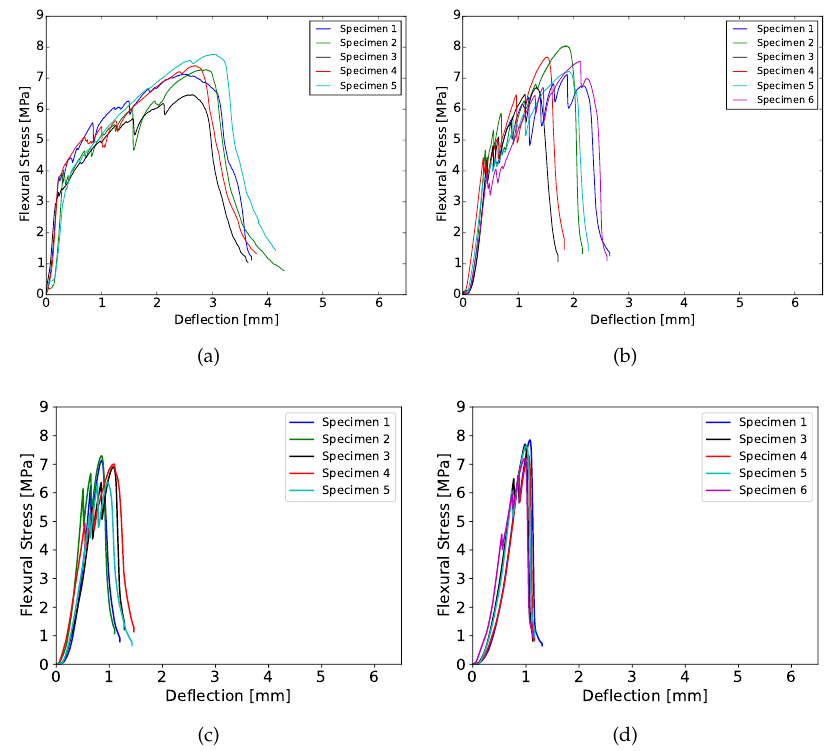
Figure 4. Flexural hardening behavior for XVA3PVA20 samples cured for 28 days. ( a ) 1 layer; ( b ) 2 layers; ( c ) 3 layers; ( d ) 4 layers.